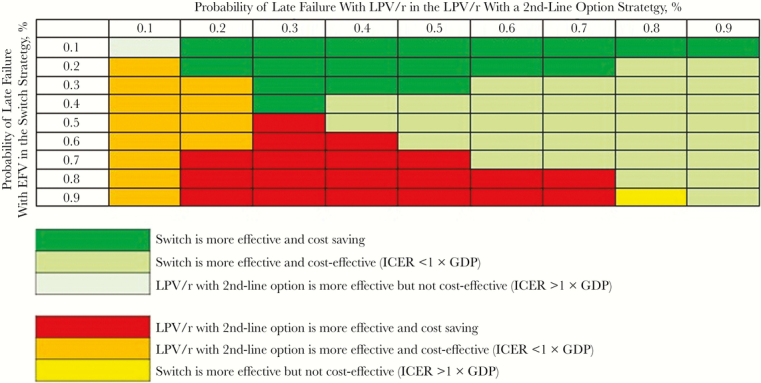
Multivariate sensitivity analyses: impact of simultaneous variation in monthly risk of late failure on preemptive switch to efavirenz (EFV) or first-line ritonavir-boosted lopinavir (LPV/r). The monthly risk of late failure of the preemptive EFV-based regimen is shown on the vertical axis; the monthly risk of late failure on the first-line LPV/r-based regimen is shown on the horizontal axis. This figure shows results comparing the switch strategy with that of LPV/r with second-line option (availability of nonnucleoside reverse-transcriptase inhibitor–based second-line antiretroviral therapy in case of failure with LPV/r). Costs and life-years are discounted at 3% per year. Following World Health Organization gross domestic product (GDP)–based guidance, cost-effectiveness results support the choice of switching in the green-shaded scenarios and the choice of LPV/r with second-line option in the red-, orange-, and yellow-shaded scenarios. Abbreviation: ICER, incremental cost-effectiveness ratio.